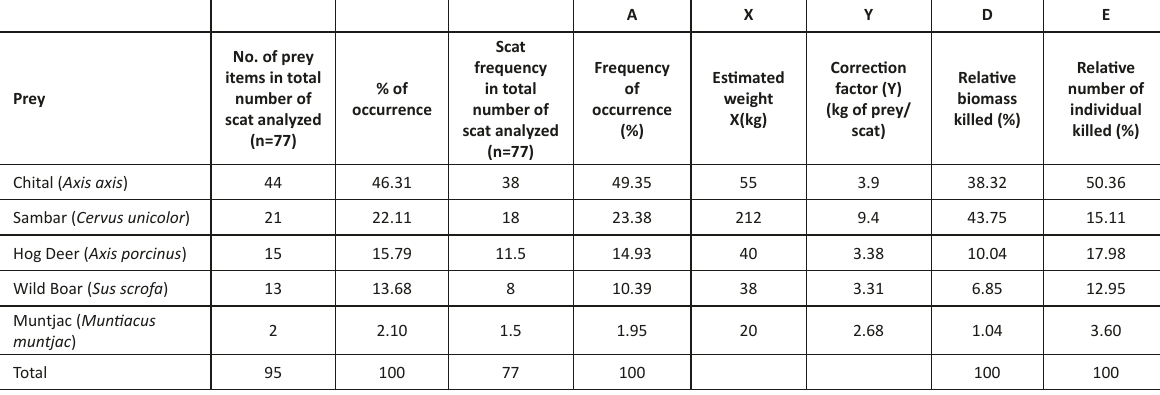
Table 1. Prey species composition in tiger scats (n = 77) and their percentage occurrence, frequency of occurrence and calculation of relative biomass and relative number of prey individuals killed by tigers, based on the scats collected in the Chitwan National Park during the tiger survey between January to March, 2010.